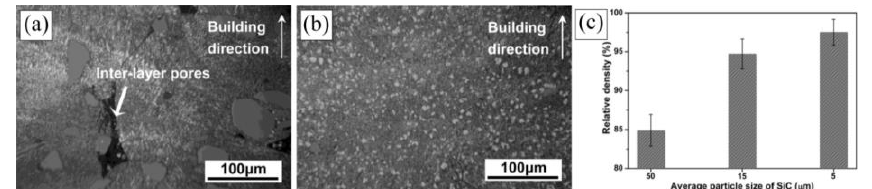
Figure 11. Cross-sectional optical micrographs of SLM-processed SiC / AlSi10Mg mixed powder system containing: ( a ) coarse and ( b ) fine starting SiC powder particles. ( c ) The change in relative density of parts as a function of SiC average particle size [102].